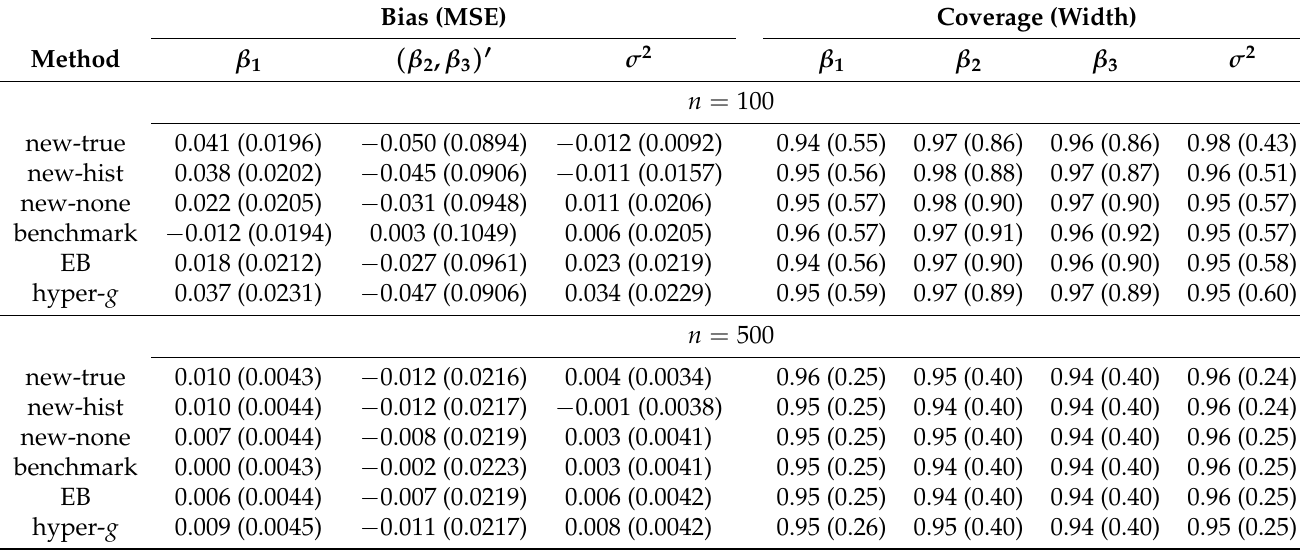
Table 1. Simulation I: Average biases (MSEs), coverage probabilities (interval widths) across 500 MC replicates in the simulation study for parameter estimation. Here, new-true, new-hist and new-none corresponds to the three hyperprior versions (V1), (V2) and (V3), respectively. Bias